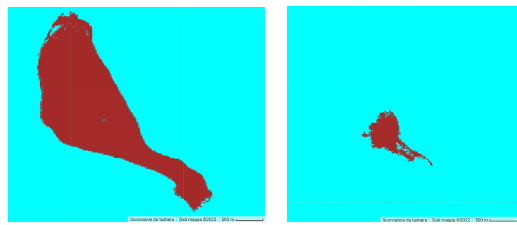
Figure 11. Water detection image on January-March 2020 (left) and January-March 2022 (right).